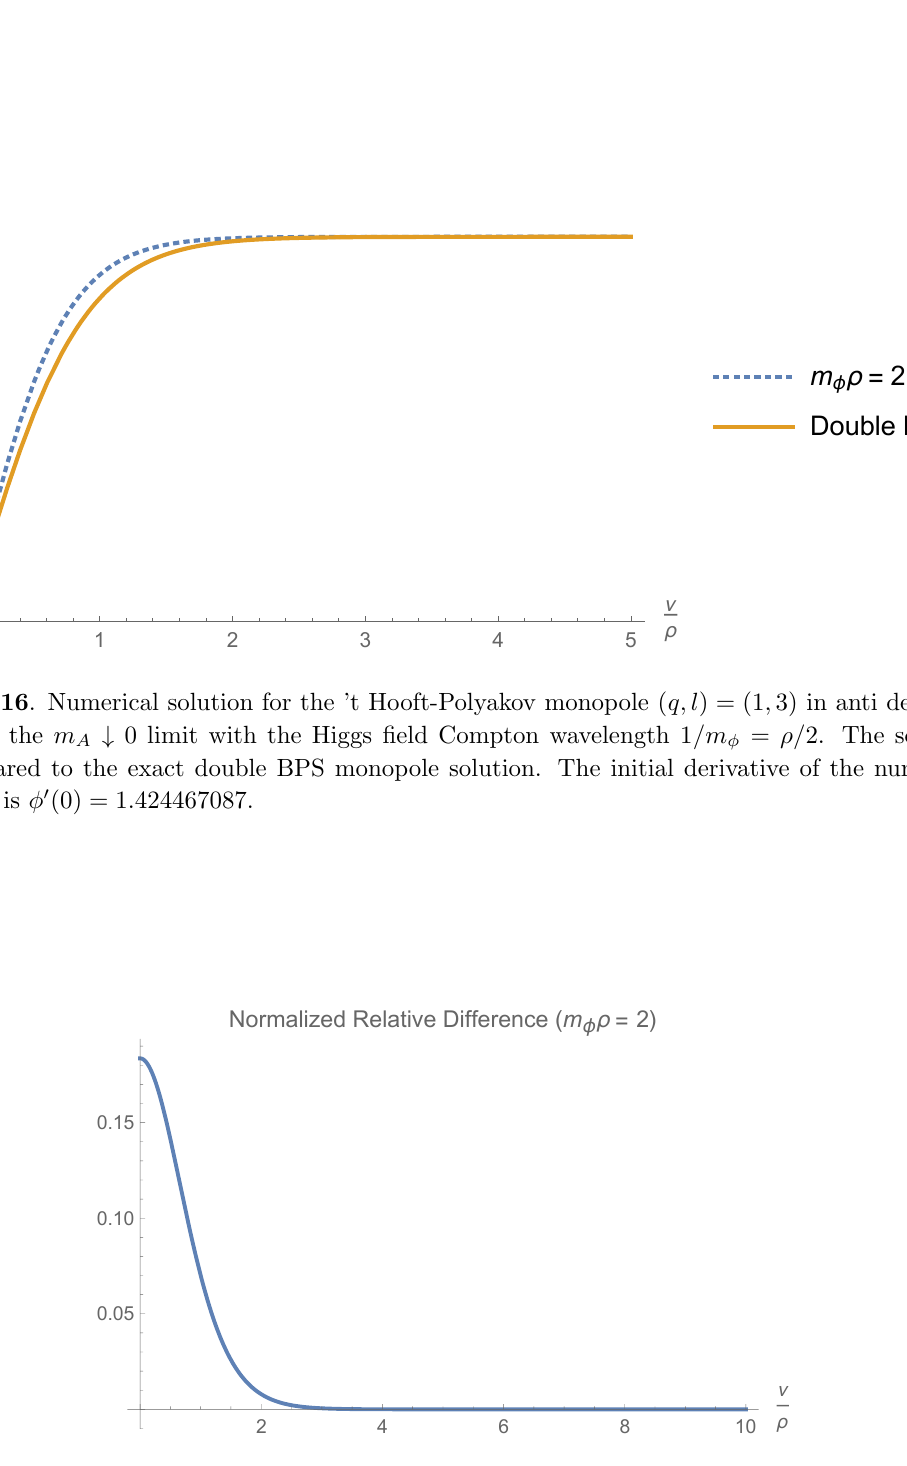
Figure 17 . Normalized relative di(cid:11)erence between the numerical monopole solution and the exact double BPS solution. The normalized relative di(cid:11)erence is de(cid:12)ned by j (cid:30) ( (cid:23) ) (cid:0) (cid:30) dBPS ( (cid:23) ) j is the exact double BPS solution. With m (cid:30) (cid:26) = 2, the normalized relative di(cid:11)erence is less than 20%.